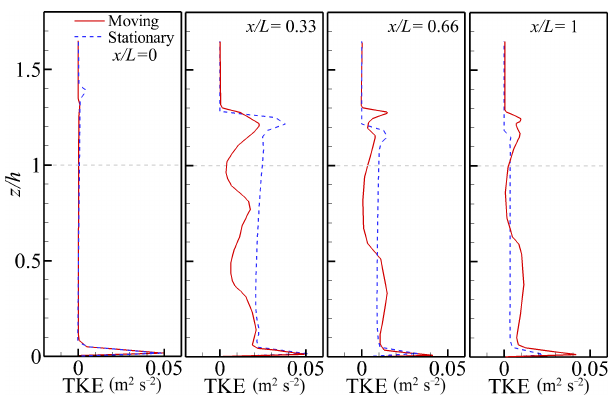
Figure 15. Comparison of vertical profiles of TKE as wave crest passes through each section, H i = 0.05m.